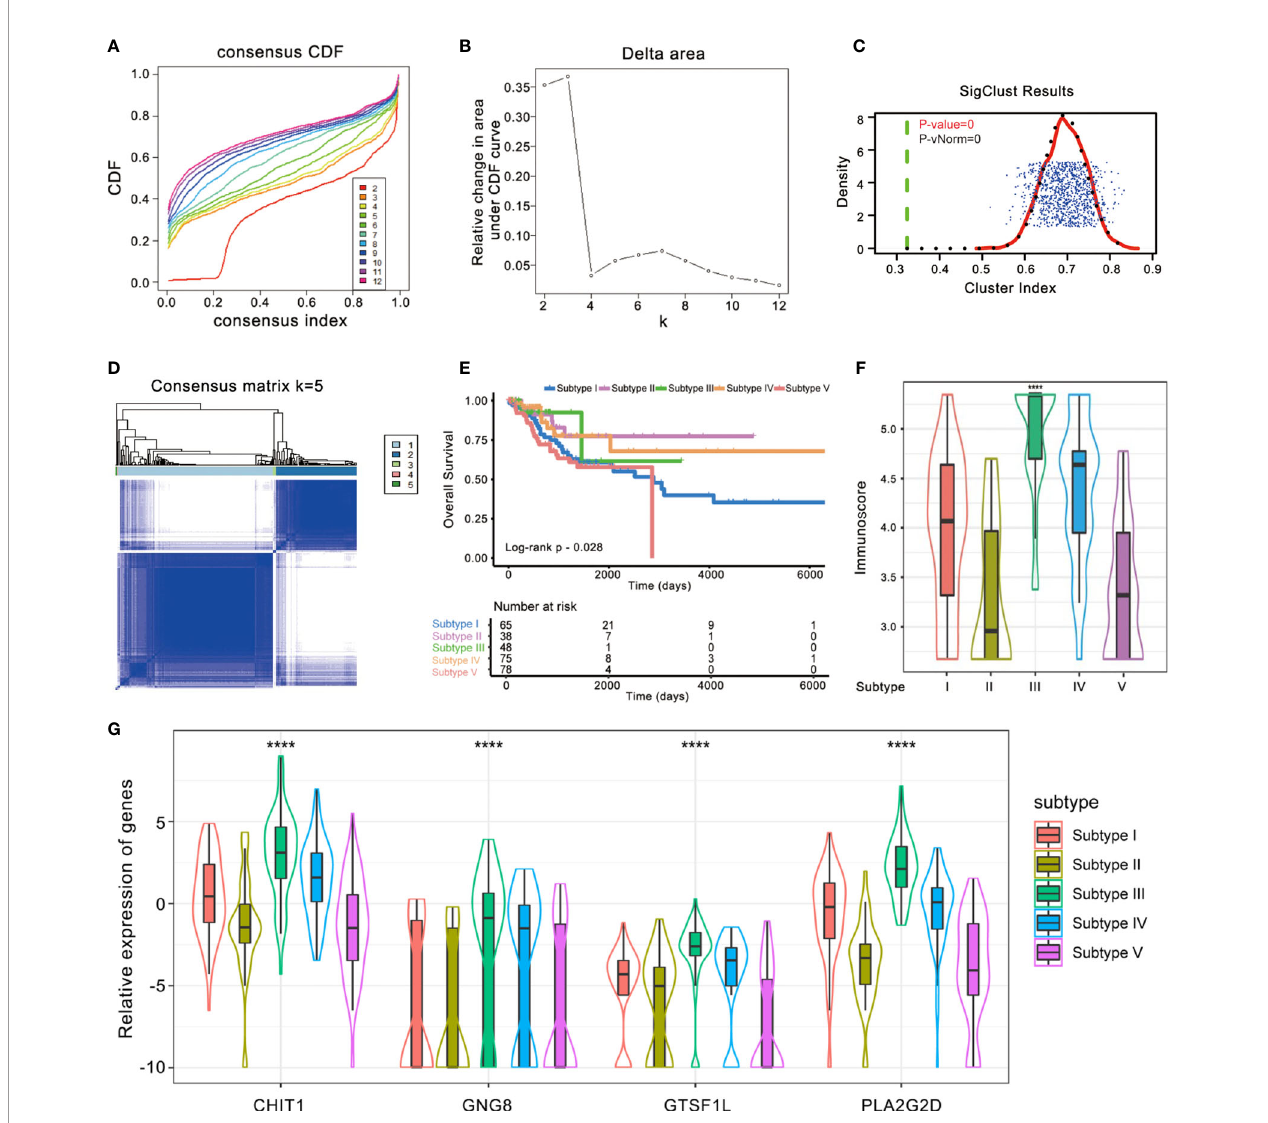
FIGURE 6 | Identi fi cation of immunogenic subtypes of the CESC cohort. (A – D) Unsupervised clustering of CESC samples based on their tumor-in fi ltrating patterns to classify patients into fi ve subgroups. (E) Kaplan – Meier curves for the fi ve groups of patients. The Log-rank test showed an overall p = 0.028. (F) The Immunoscore of fi ve immune subtype clusters. The statistical difference of fi ve clusters was compared through the Kruskal – Wallis test. **** p < 0.0001. (G) Difference in the four immune-related gene expressions among distinct immune clusters (Kruskal – Wallis test, p <